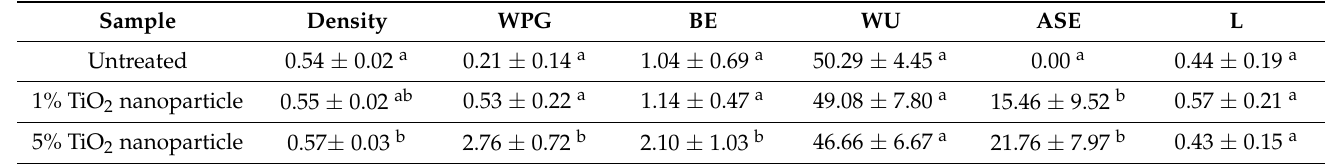
Table 1. Value of dimensional stability and density of mangium wood.